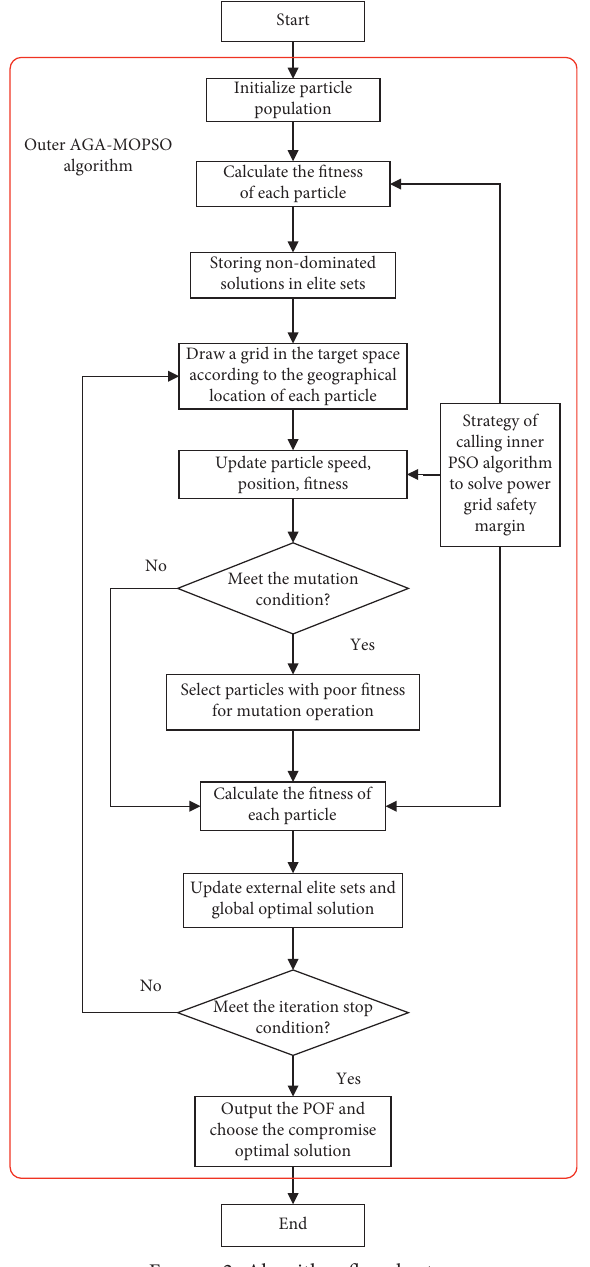
Figure 2: Algorithm